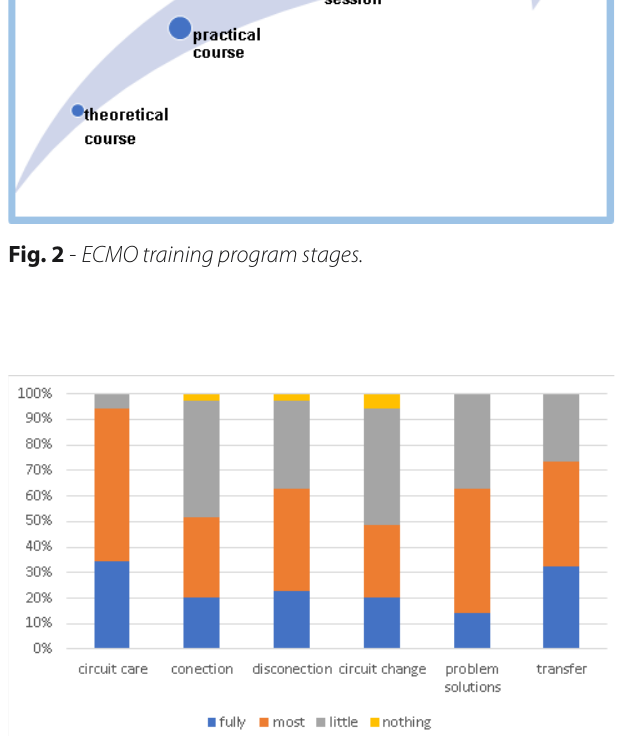
Fig. 3 - Perceived skills to solve situations after training. Confidence in ECMO circuit care was higher than in other situations.